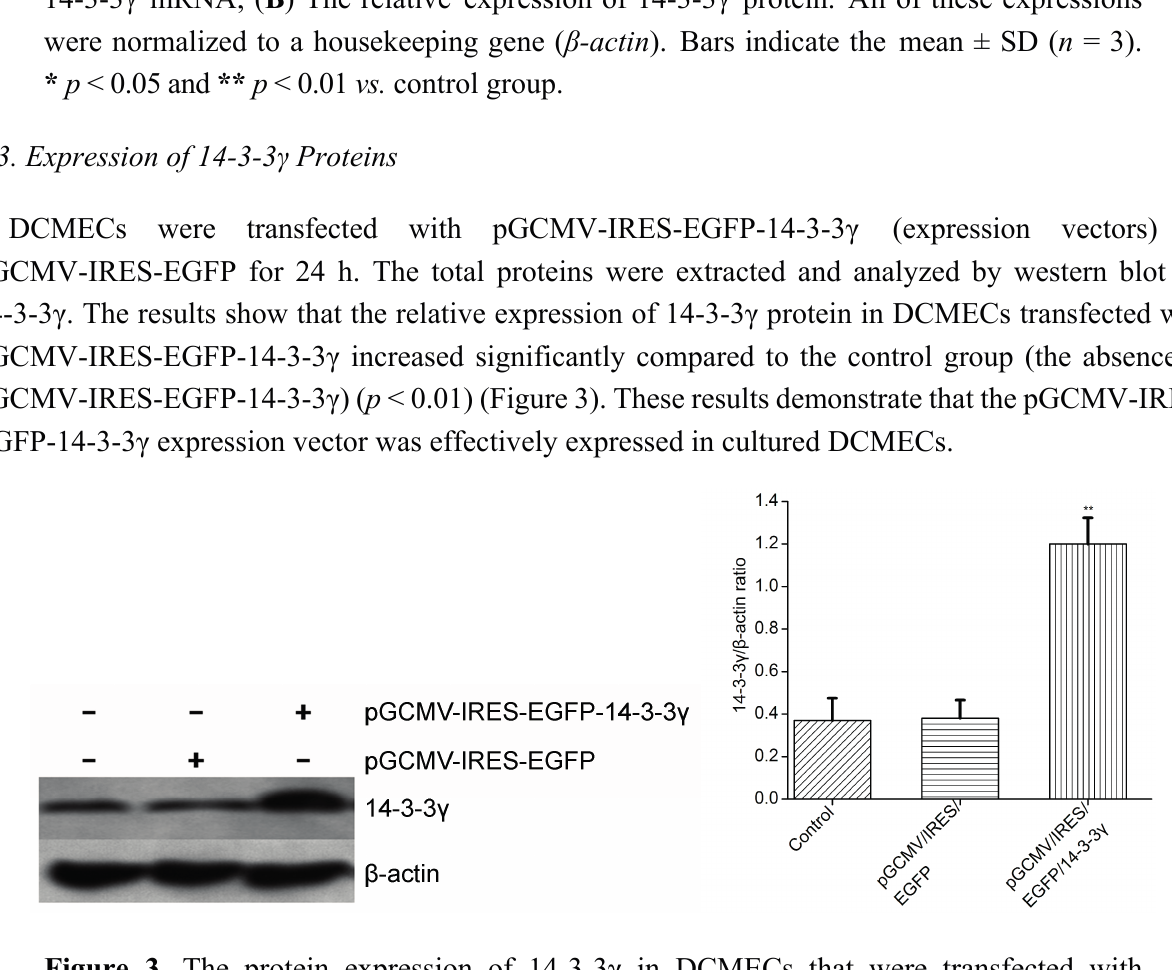
Figure 3. The protein expression of 14-3-3 γ in DCMECs that were transfected with pGCMV-IRES-EGFP-14-3-3 γ (expression vectors) for 24 h. The relative expression of the 14-3-3 γ protein was determined by normalization to β -actin . Bars indicate the mean ± SD ( n = 3). ** p < 0.01 vs. control